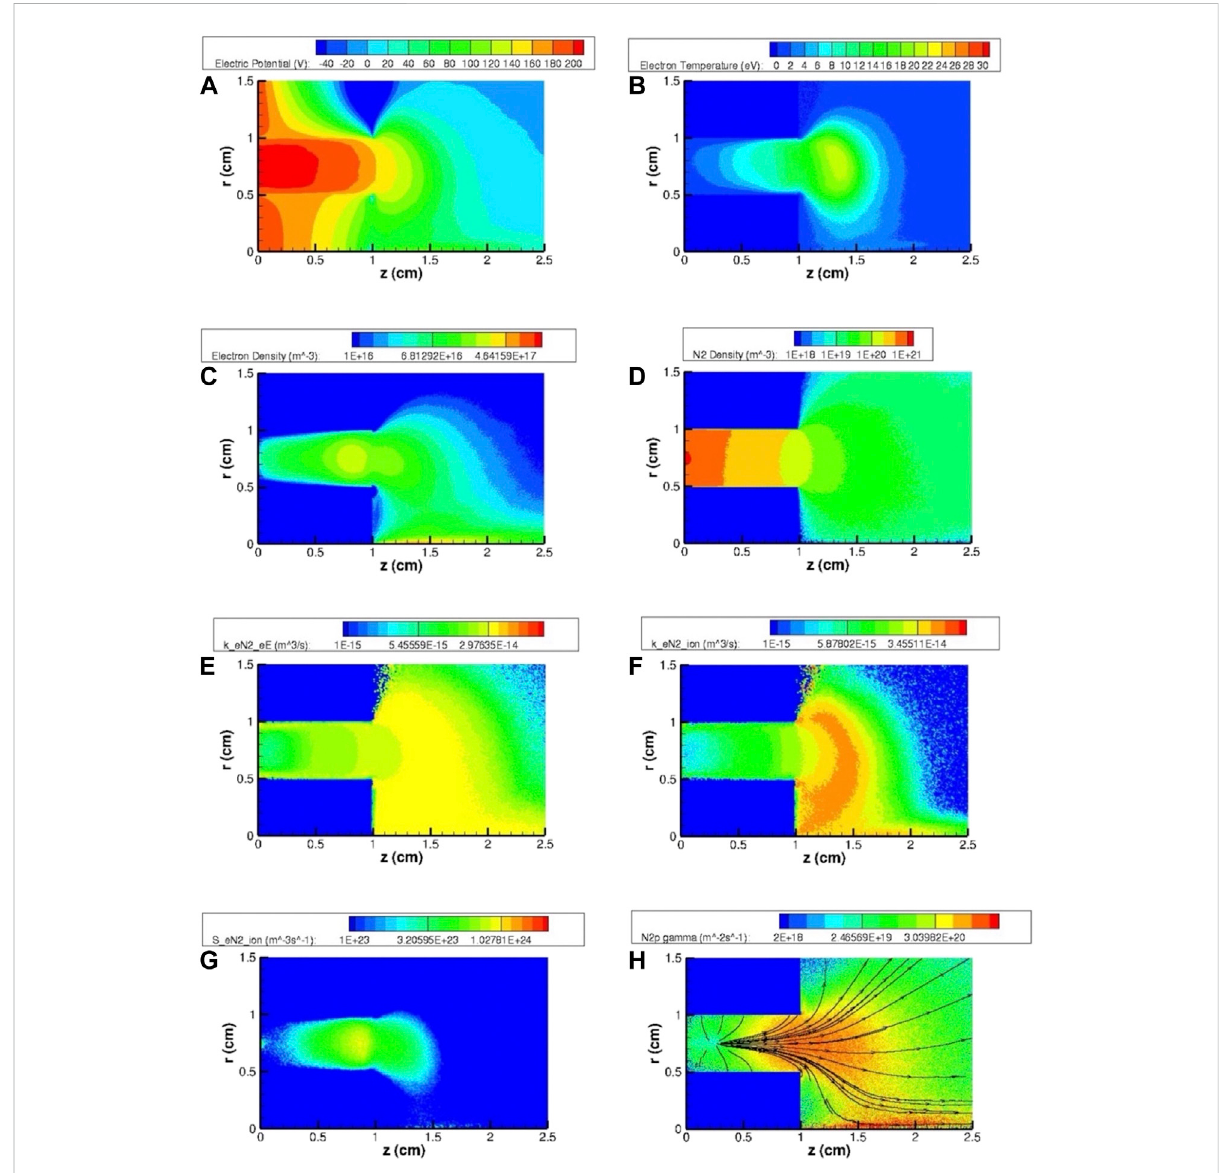
FIGURE 8 Two-dimensional maps of the most relevant HT plasma and gas parameters for the SPT20 nominal case using N 2 (case B) as the propellant: (A) electricpotential ϕ (V), (B) electrontemperature T e (eV), (C) electrondensity n e (m − 3 ), (D) atomicdensity n N ionization rate coef fi cients, k eE , N and k ion , N (m 3 s − 1 ) (Eq. 18), (G) ionization source term S ion , N 2 2 averaging over the last 1500 PIC cycles for plasma quantities (A – C,E – H) and over the last 1500 TPMC iterations for gas quantity (D)